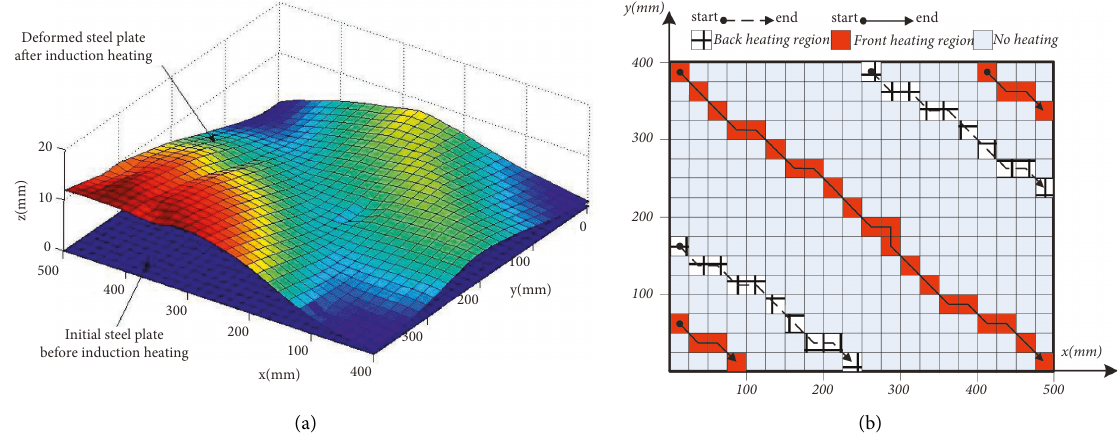
Figure 9: Measurement results: (a) wavy transformation on nonsymmetric steel plate and (b) predicted regions and its relative